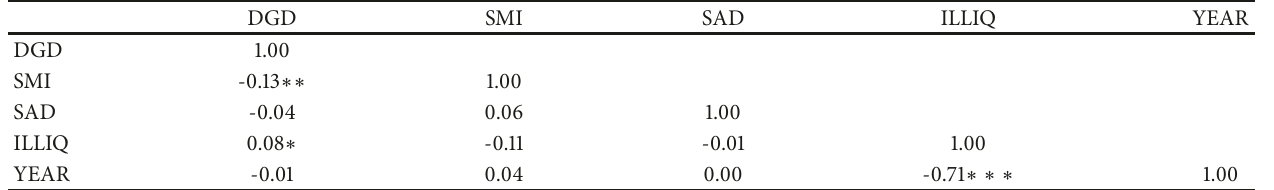
Table 3: Correlation Matrix.